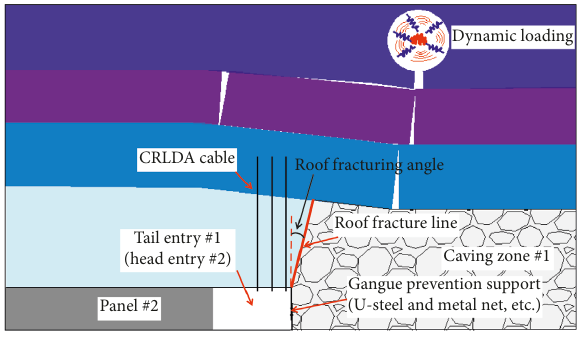
Figure 3: Schematic of the roof caving